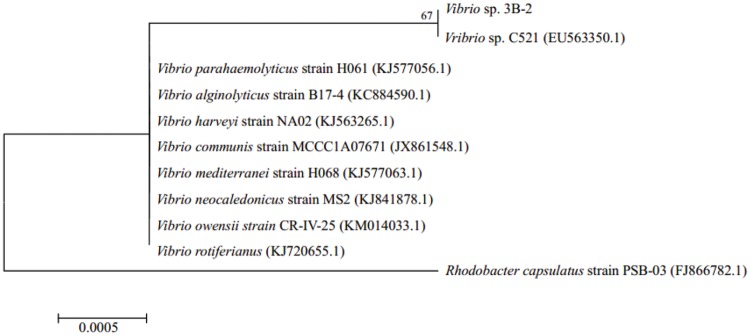
Maximum-likelihood tree based on 16S rDNA gene sequence of strain 3B-2 isolated from Bohai Bay sediment (1169 bp) and those of known relatives retrieved from the GenBank database (accession No. in brackets). Bootstrap values shown at nodes for frequencies at or above a 50% threshold (per 1000 trials bootstrap resampling). Rhodobacter capsulatus used as outgroup. Bar indicates 0.05% sequence variance.